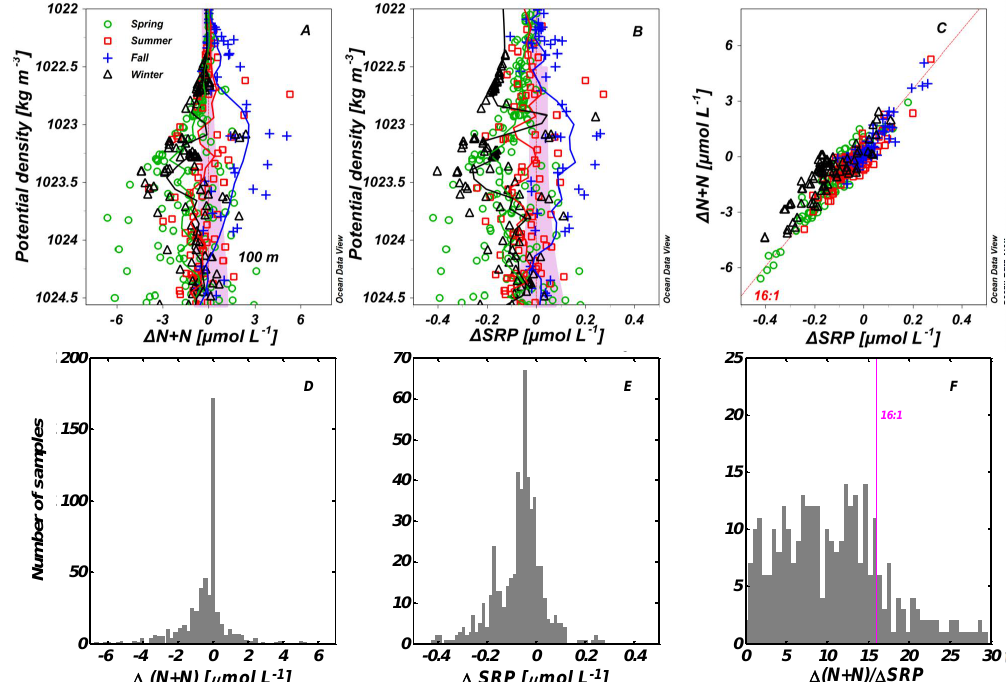
Fig. 10. 1 (N + N) (A) and 1 SRP (B) versus potential density in the upper 100m of the central NSCS. (C) The relationship between 1 (N + N) and 1 SRP. Lines in (A) and (B) represent the moving average during each season. Pink shadows in (A) and (B) indicate the X N ± S N domain (see Supplementary for details). The straight pink line in (C) denotes the theoretical correlation of 16 : 1 based on the Redfield ratio (Redfield et al., 1963). Also shown are the histogram distributions of 1 (N + N) (D) , 1 SRP (E) and 1 (N + N)/ 1 SRP (F) in the upper 100m of the central